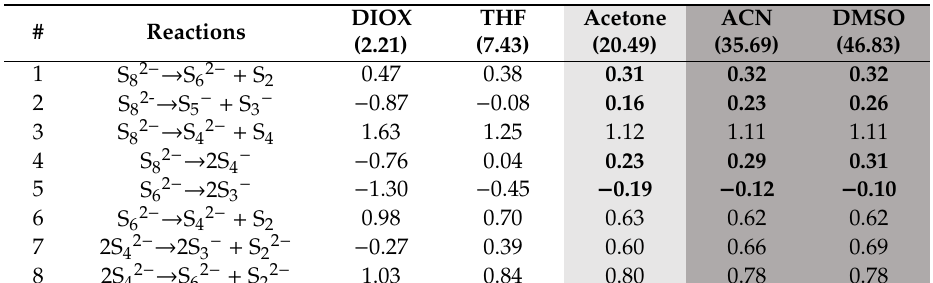
Table 1. The reaction free energies ( ∆ G, eV) of polysulfides in different solvents. The dielectric constants ( ε ) of different solvents are presented in parentheses. The solvents that tend to facilitate the reactions of the dissociated PS’s are shaded in grey, and the reaction energies for the more probable reactions are in bold.